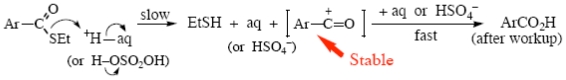
Hydrolysis of ethyl thiolbenzoates in sulfuric acid.